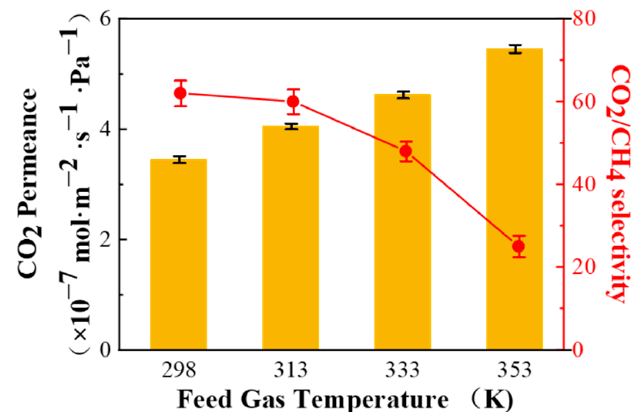
Figure 8. Effect of the feed gas temperature on the CO 2 /CH 4 (45/55 vol%) mixed gas separation performance of PPPS/PDMS/PSf composite membrane. Test conditions: saturated humidity and 0.15 MPa.